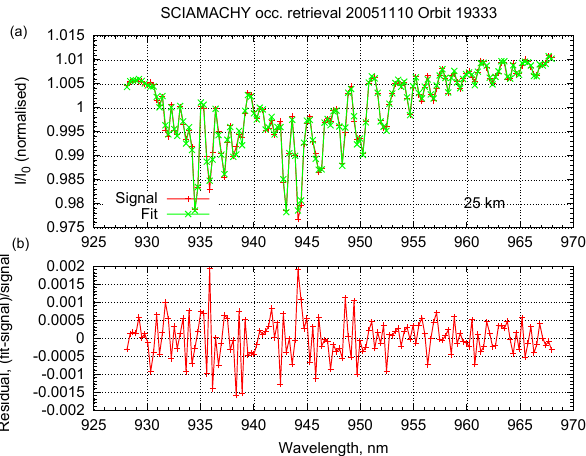
Figure 2. Example of a spectral fit. Top: normalised measured spec- trum (red line) and fitted spectrum (green line) at 25km tangent al- titude. Bottom: resulting residual, i.e. relative difference between measurement and